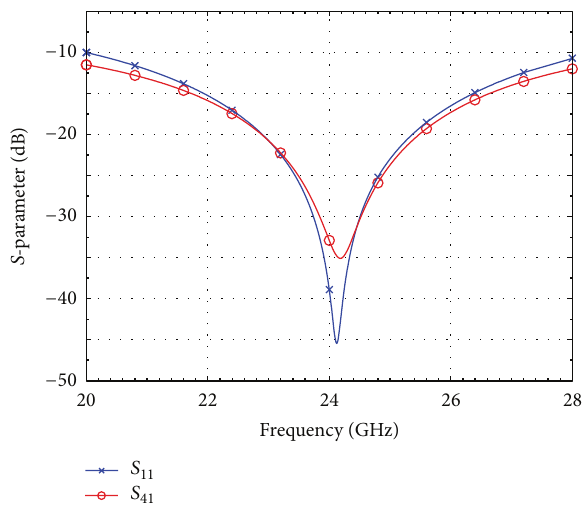
Figure 5: Simulated 𝑆 11 and 𝑆 41 of the quadrature hybrid